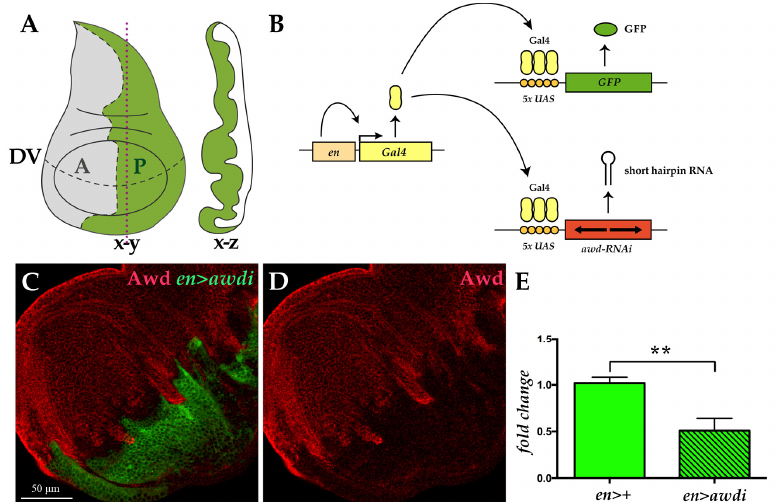
Figure 1. Transgenic RNA interference (RNAi) approach downregulates Awd. ( A ) The wing disc, like the other imaginal discs, is a sac-like structure (x-z cross section along the vertical plane indicated by red dots) composed of a single layered epithelium whose morphology matures during larval development (x-y frontal section). The dashed lines mark the boundary between anterior (A, grey) and posterior (P, green) compartments as well as the dorso-ventral (DV) boundary. ( B ) Illustration of the UAS / Gal4 expression system applied to drive targeted coexpression of the UAS-awdi and UAS - GFP transgenes. ( C , D ) Confocal microscopy image of wing disc dissected from en > awdi larvae and immunostained for Awd (red in C , D ). ( E ) qRT-PCR analysis of awd transcript level in cephalic complexes and wing discs dissected from larvae of the reported genotypes. Graphs represent mean ± SD; n = 3; ** = p < 0.01.